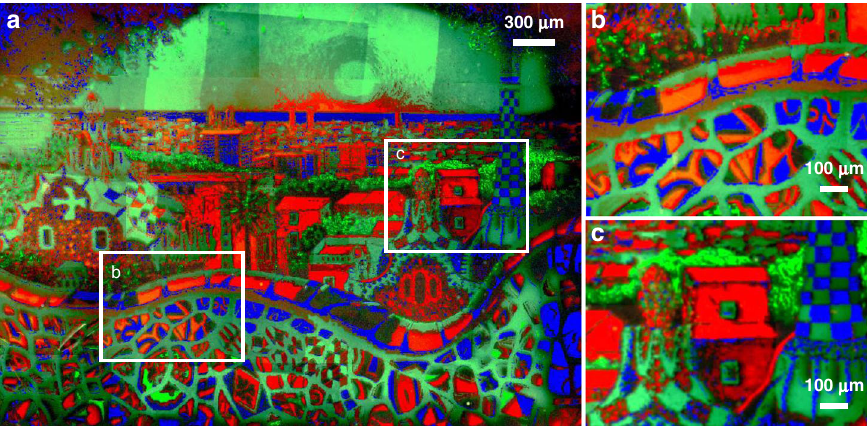
Fig. 3 Multicomponent polymer brush patterns. a Composite of 75 microscopy images (25 images per channel) showing all three different fl uorophores utilized to print an image of the Barcelona skyline (courtesy of Ana Maria Edulescu). b and c magni fi cation of the areas marked in a